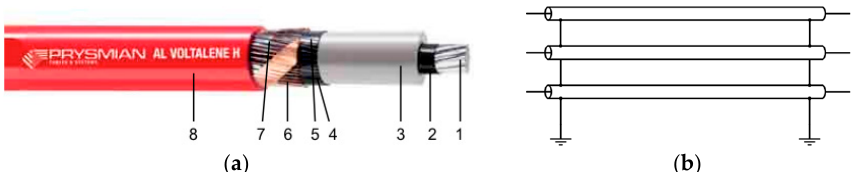
Figure 2. (a) Underground wire (AL RHZ1-OL, Prysmian™). (1) Aluminum conductor, (2) Intern semiconductor, (3) Insulator, (4) Extern semiconductor, (5) Water protection, (6) Cupper sheath, (7) Separator, (8) External cover; and (b) most common sheath connection for short segments of underground MV primary distribution lines in Spain.